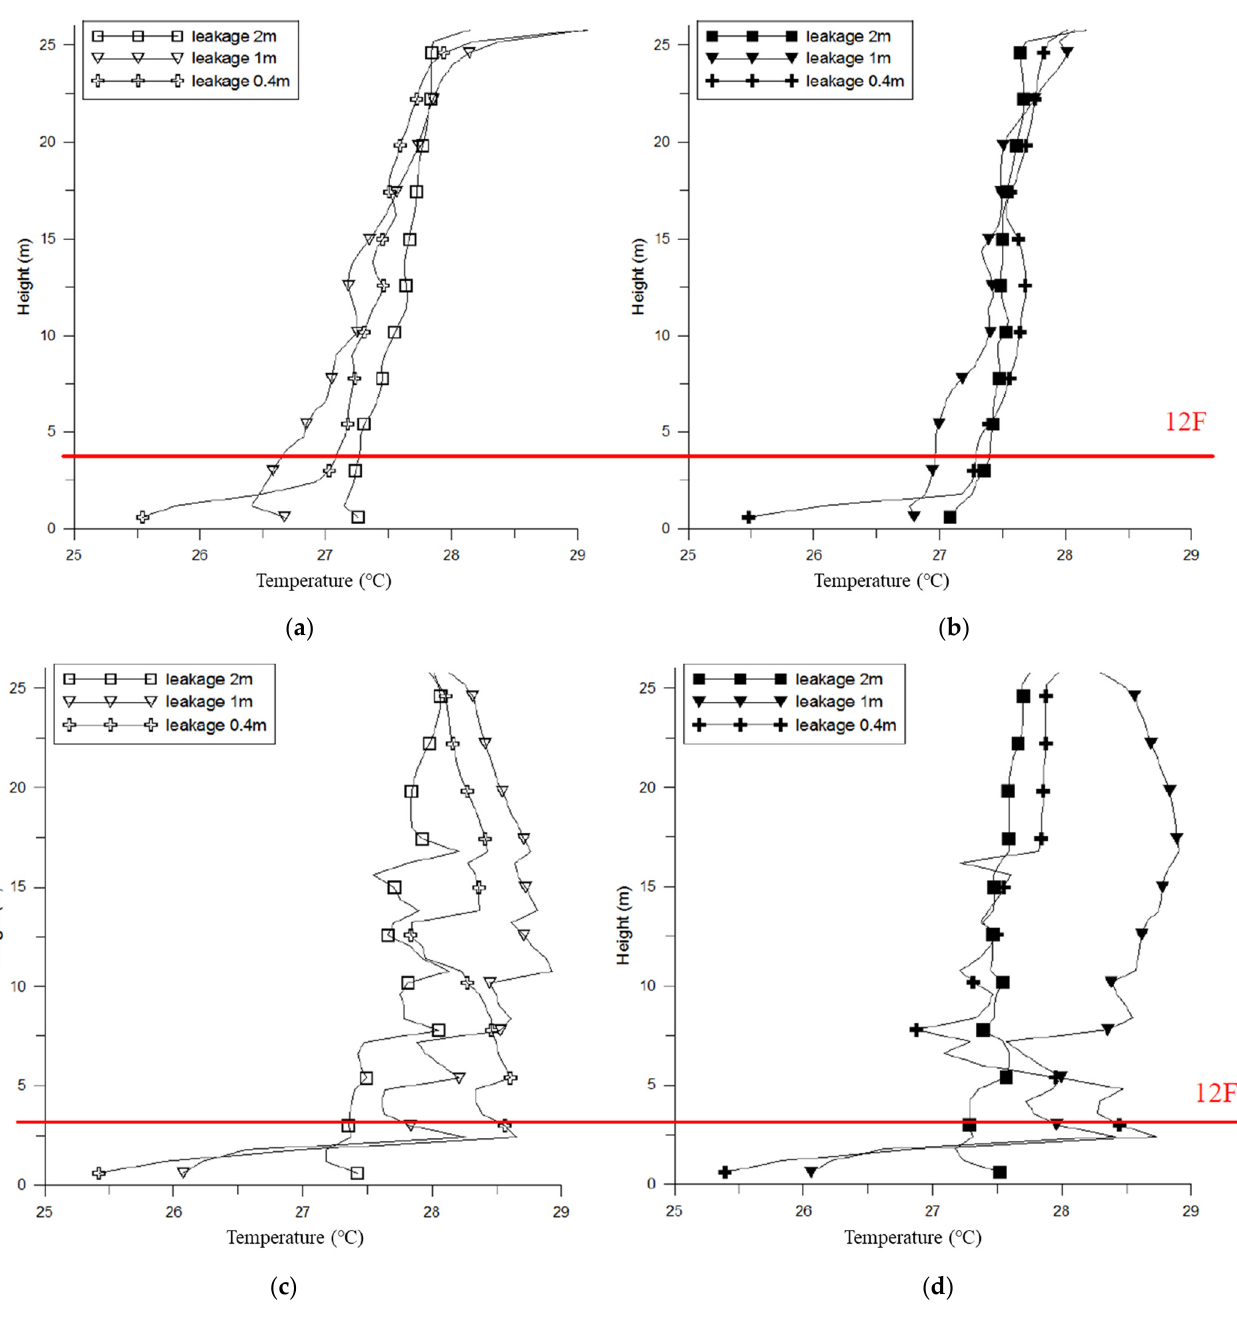
Figure 21. Vertical temperature distribution with various handrail heights. ( a ) Vertical temperature distribution in middle section of atrium with 1.1-m handrails. ( b ) Vertical temperature distribution in middle section of atrium with 1.9-m handrails. ( c ) Vertical temperature distribution in outer ring of atrium with 1.1-m handrails. ( d ) Vertical temperature distribution in outer ring of atrium with 1.9-m handrails.